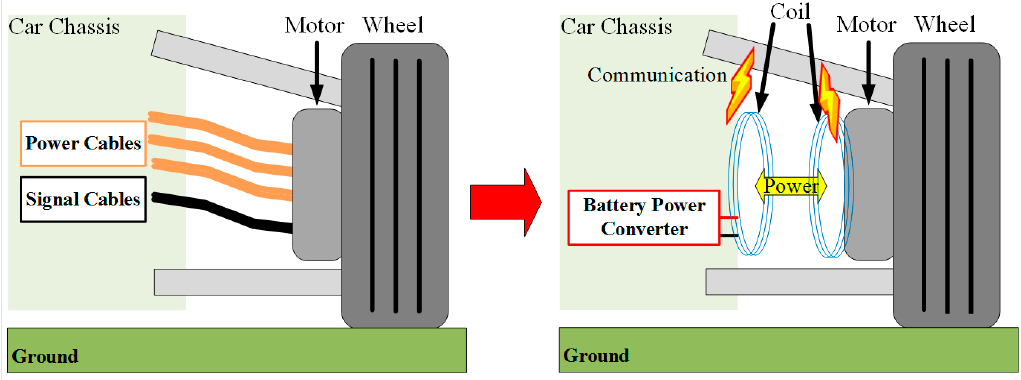
Figure 17. W-IWM setup showing efficiency at 100% torque reference. Adapted from [26]. 3.2. HEV Setup